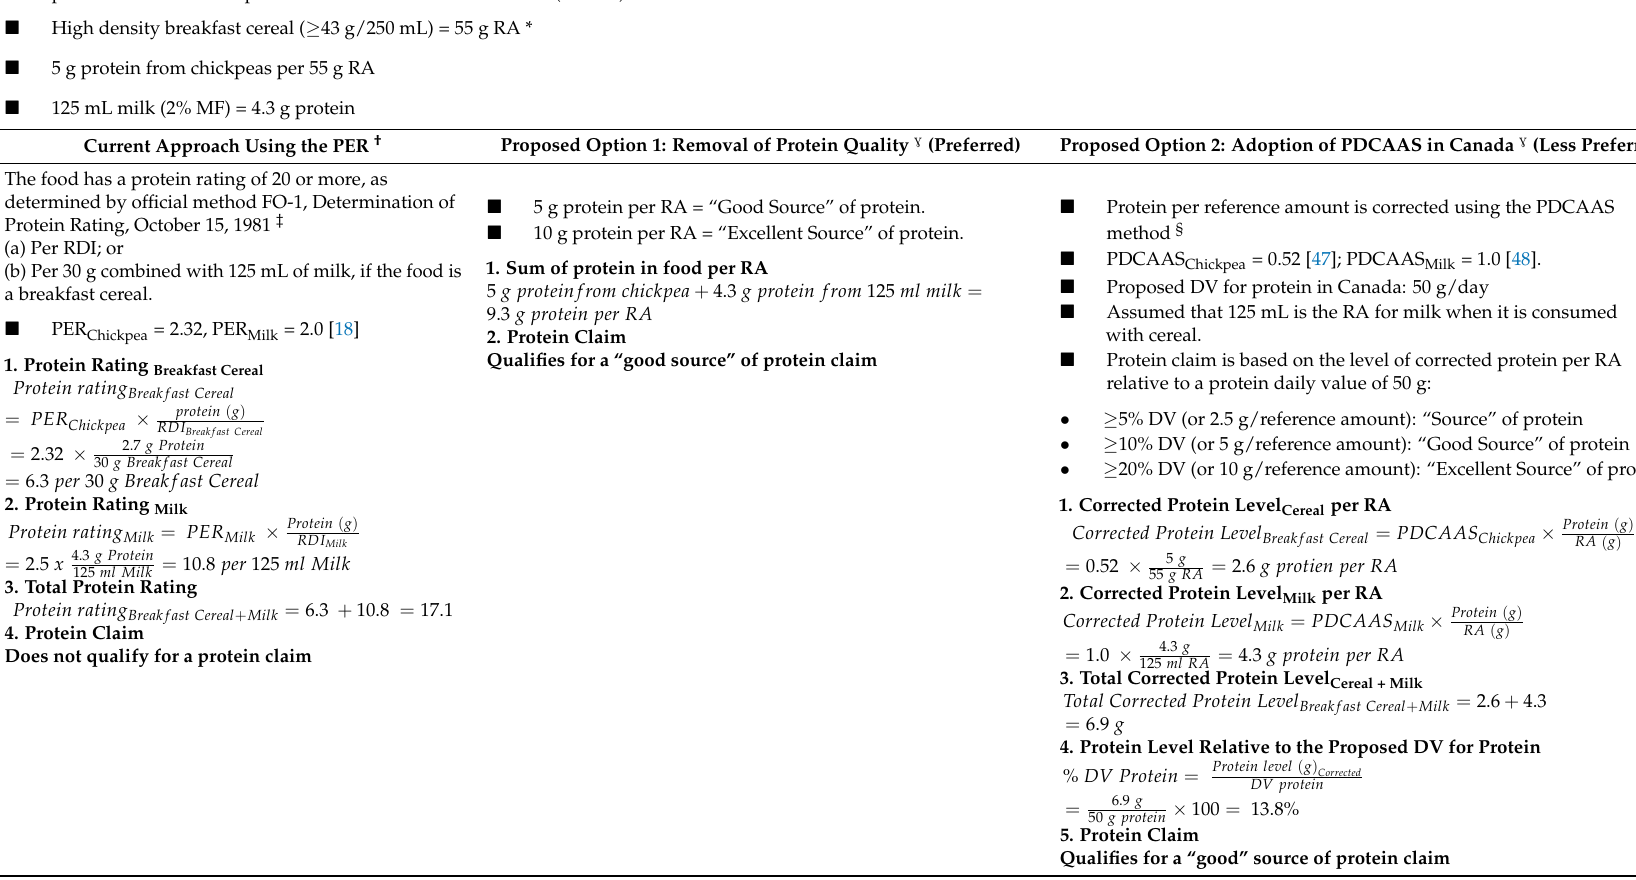
Table 4. An example that demonstrates the current and proposed approaches for qualifying for protein content claims in Canada when ≥ 2 distinct finished foods are traditionally combined prior to consumption.